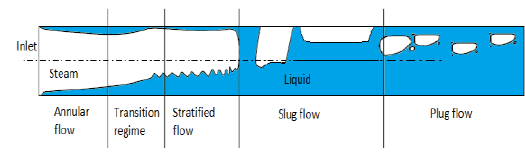
Fig. 3. Flow patterns during condensation in horizontal tube [4].